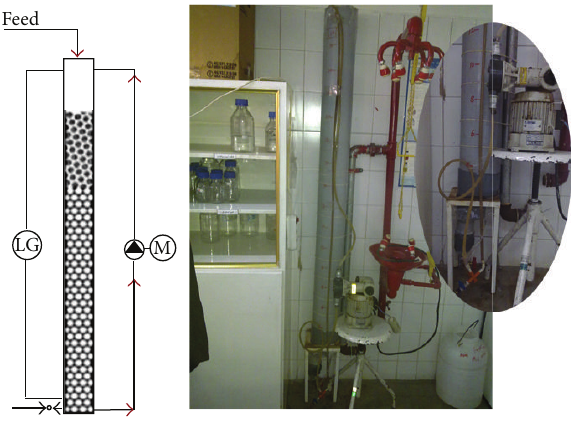
Figure 1: Start-up pilot.